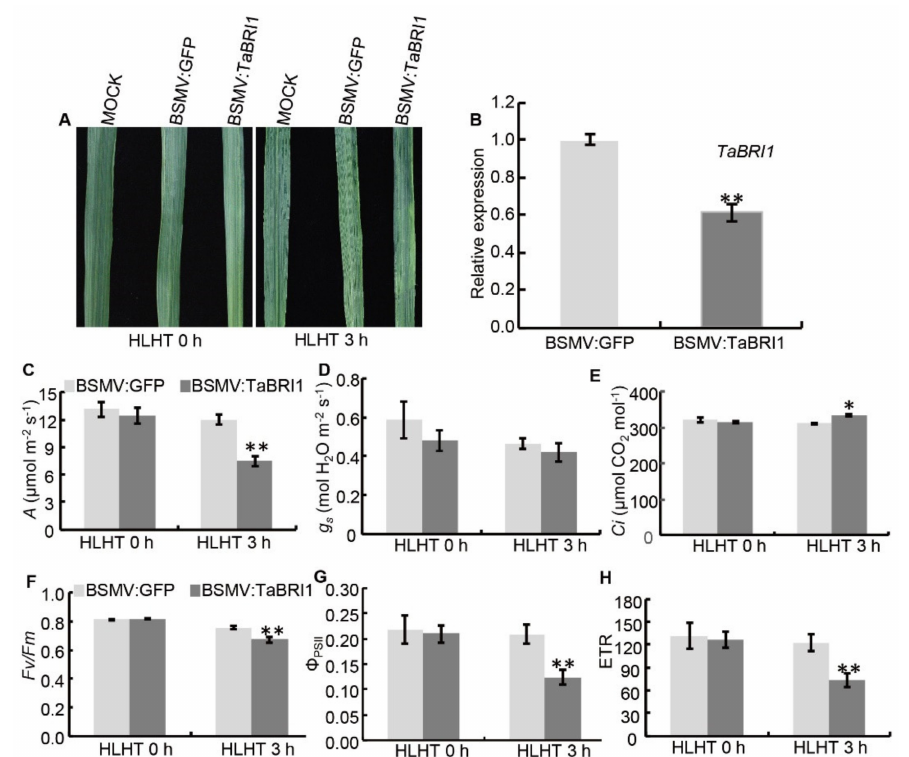
(Figure 9A). The expression level of TaBRI1 in the BSMV: TaBRI1 plants was significantly decreased compared that in the BSMV:GFP plants, indicating that TaBRI1 was e ff ectively silenced (Figure 9B). Under HLHT stresses for 3 h, CO 2 assimilation rate, stomatal conductance ( gs ), intercellular CO 2 partial pressure in the BSMV: TaBRI1 plants were significantly lower than those in the BSMV:GFP plants (Figure 9C–E). Meanwhile, the Fv / Fm , Φ PSII and ETRs of PSII e ffi ciency parameters in the BSMV: TaBRI1 -infected plants decreased by 11.1%, 40.4% and 40.4%, respectively compared with those in BSMV:GFP plants under HLHT 3 h (Figure 9F–H). In contrast, no significant di ff erences were observed in the photosynthetic parameters (A, Gs and Ci) and the e ffi ciency of PSII ( Fv / Fm , Φ PSII and ETRs) between the BSMV:GFP and BSMV: TaBRI1 plants under normal conditions (Figure 9C–H).